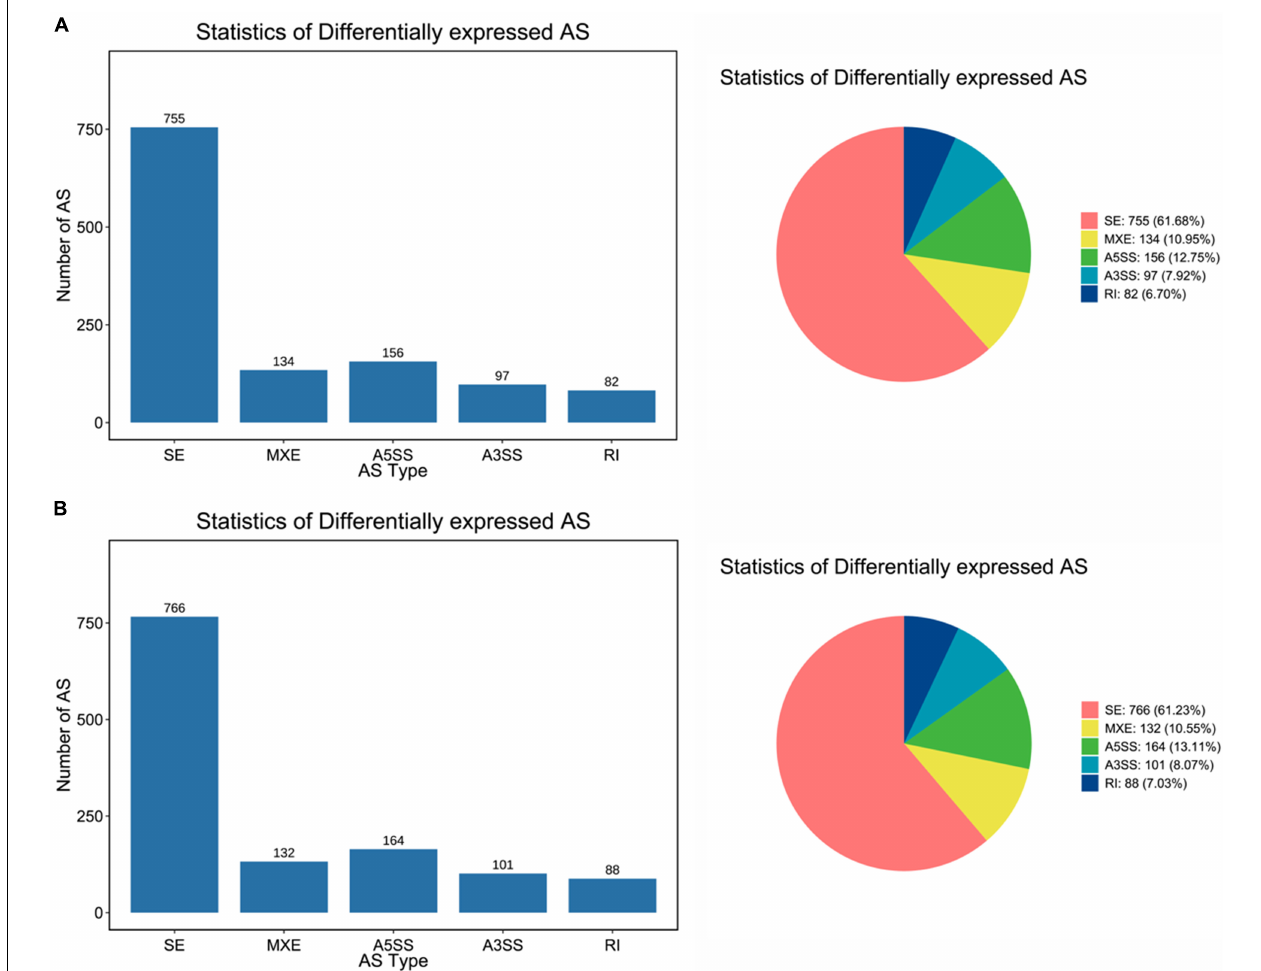
FIGURE 1 | Analysis of alternative splicing (AS) events after HS. (A) The number of differentially expressed AS events after 48 h heat shock (48 h_HS) as compared with control (CO) sea cucumbers using the splice junction counts (JC only) as the input for rMATS. (B) The number of differentially expressed AS events in 48 h_HS vs. CO using reads on target and junction counts (JCEC) as the input for rMATS. SE, skipped exon; A5SS, alternative 5 (cid:48) splice site; A3SS, alternative 3 (cid:48) splice site; MXE, mutually exclusive exon, and RI, retained intron.